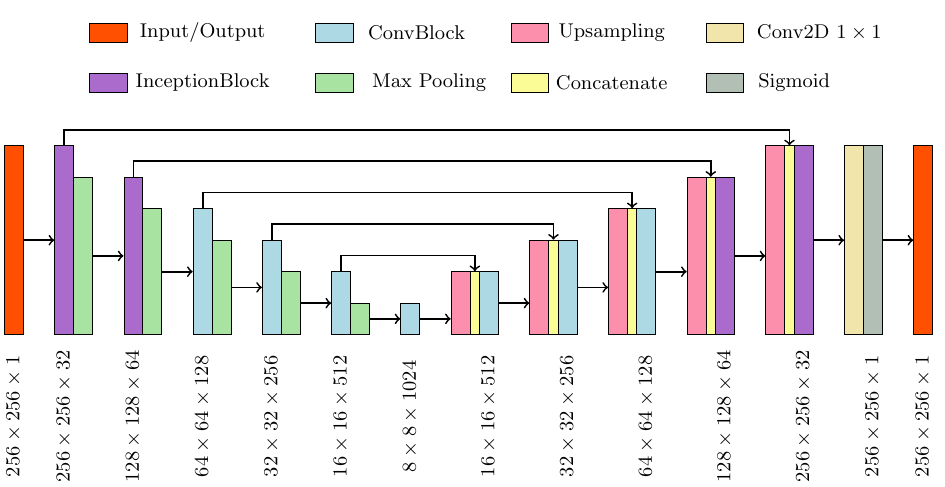
Figure 2. Schematic of the generator network